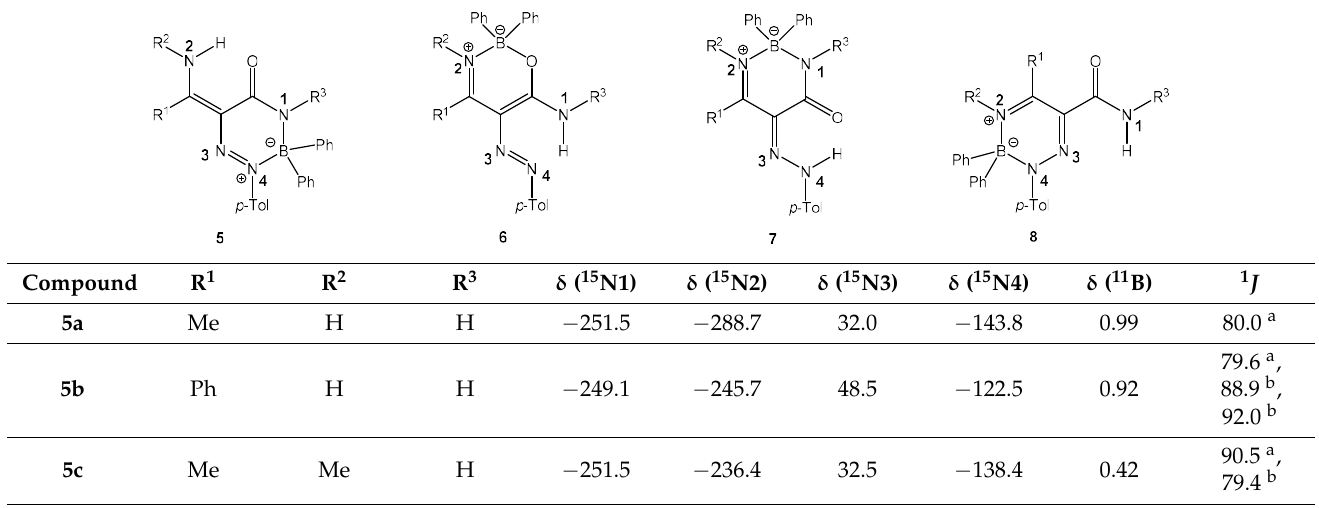
Table 2. NMR parameters for prepared boron heterocyclic compounds 5 – 9 .